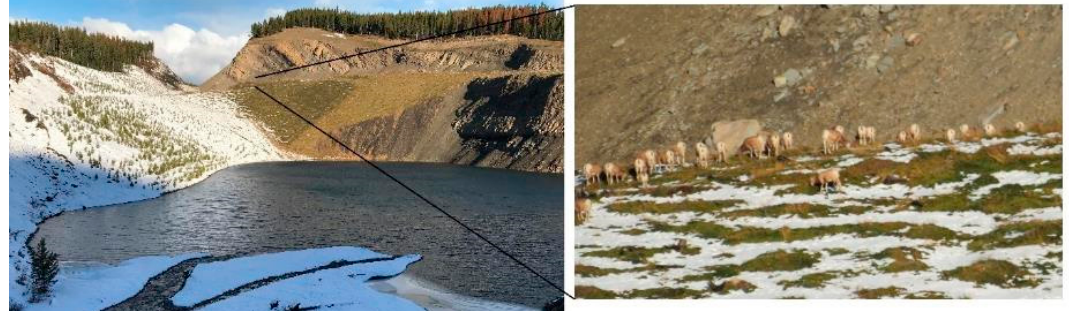
Figure 2. Bighorn Sheep taking advantage of the steep habitat created around Sphinx Pit Lake, Alberta, Canada.